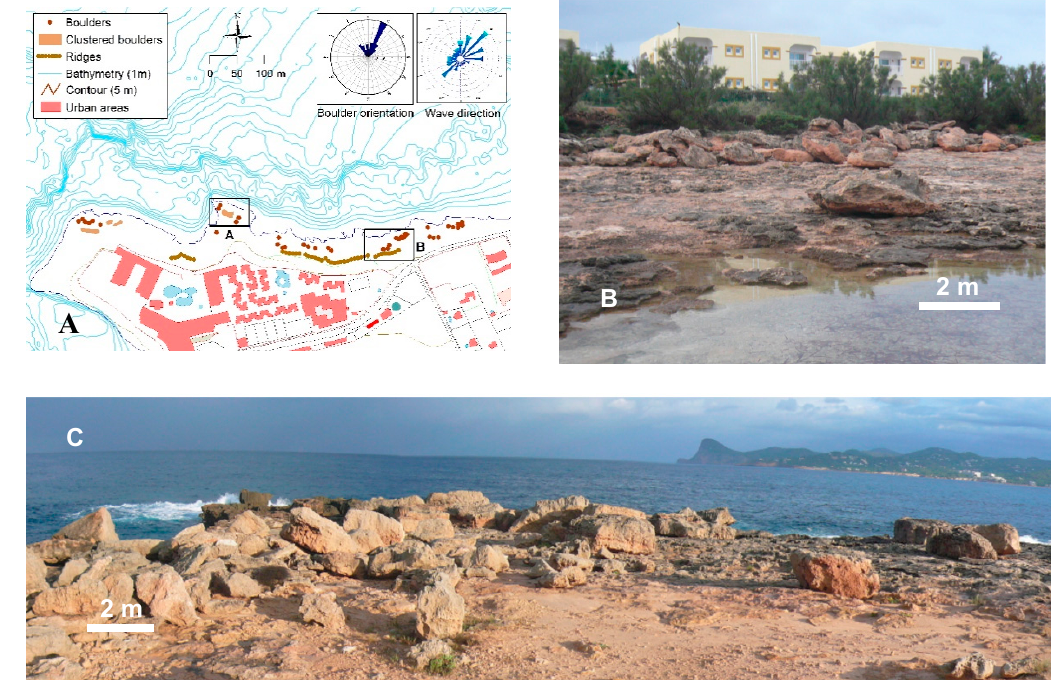
Figure 6. ( A ) Geomorphological scheme of the Sant Antoni area. Roses show the dominant orientation of boulders ( left ) and the prevailing waves ( right ). ( B ) and ( C ) Ridges of boulders very close to sea level at Sant Antoni.